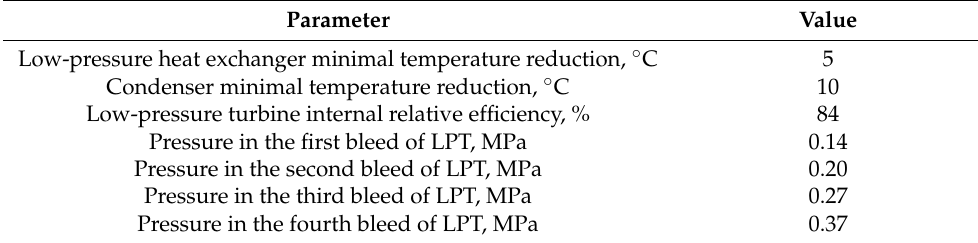
Table 4. Simulation input data for Case